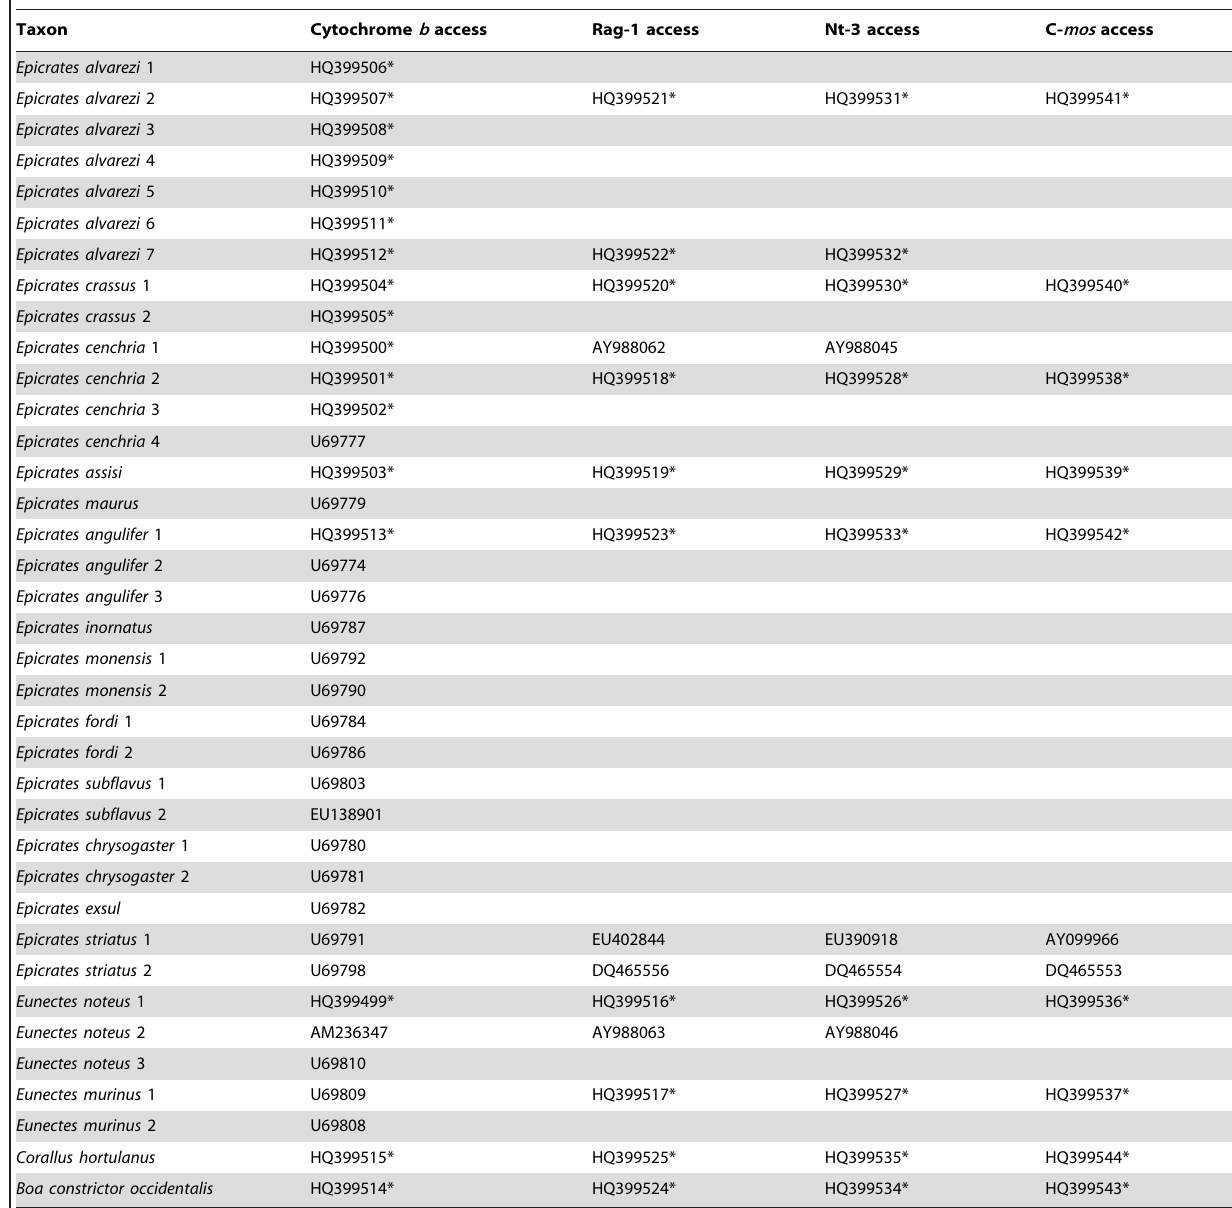
Table 6. List of the species and accession numbers of the sequences used in this